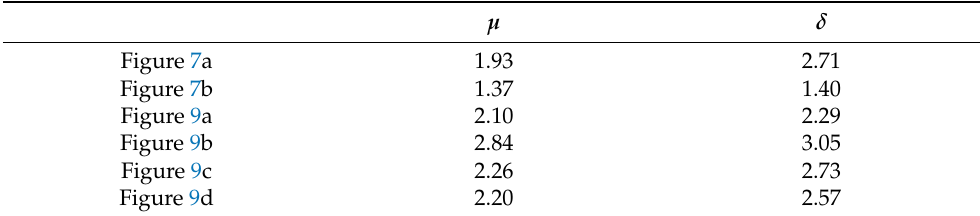
Table 2. µ and δ for our method compared with the Table 2. µ and  for our method compared with the FEKO-MLFMM.